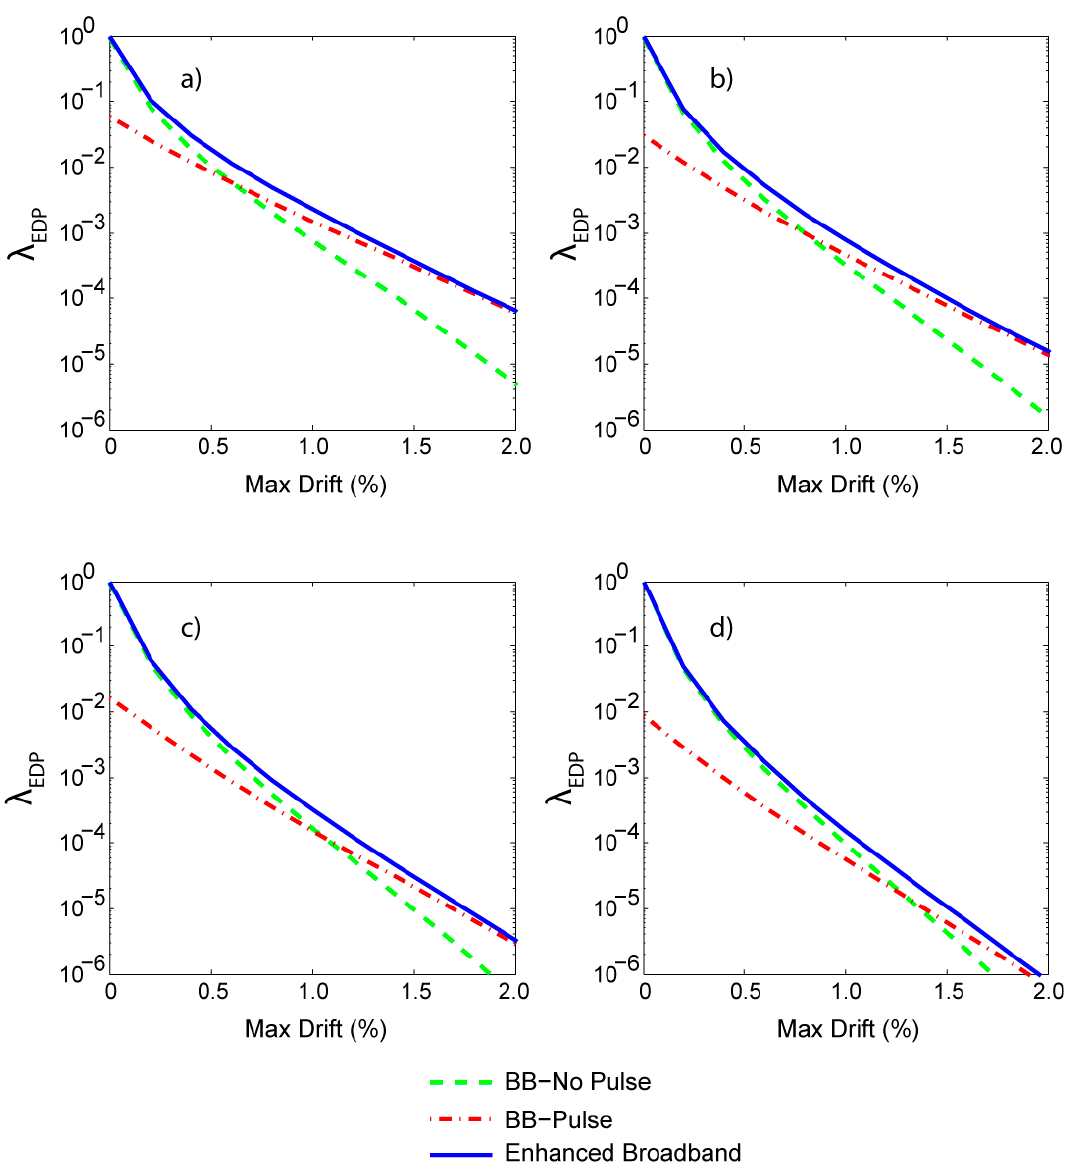
Figure 11. Rate of exceedance of drift vs. maximum drifts from the enhanced broadband approach, and the individual contributions of pulse and non-pulse motions are shown for sites located at a distance of ( a ) 6 m, ( b ) 11 km, ( c ) 16 km, and ( d ) 21 km from the fault.